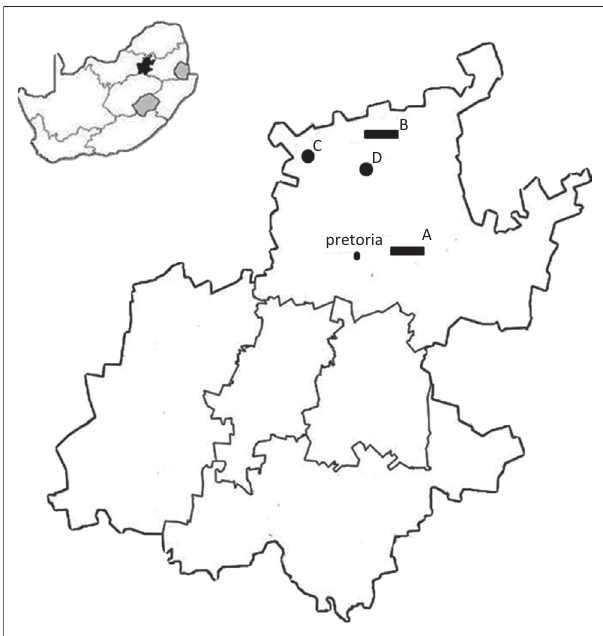
FIGURE 1: A map of Gauteng Province showing the four clinics and/or sites where the samples were